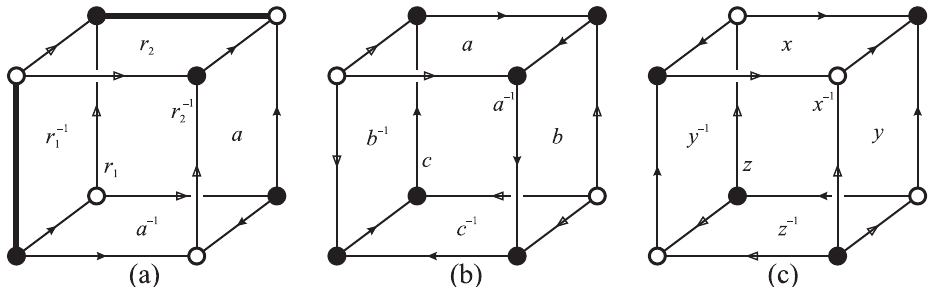
Figure 9. The only face identification of the cube determining the hyperbolic fundamental tiling { 4,3,5 } by the space group G ( 5 ) ( a ). The two additional ones generate the fixed point free hyperbolic ( 6 ) ( 6 ) space groups G ( b ) and G ( c ) to tiling {4, 3, 6} i b